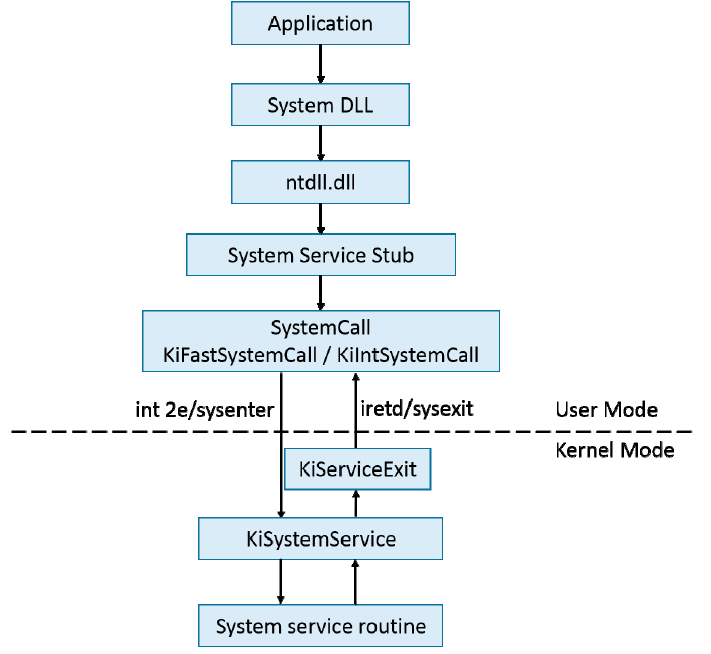
Figure 1. Execution flow of invoking a system service.